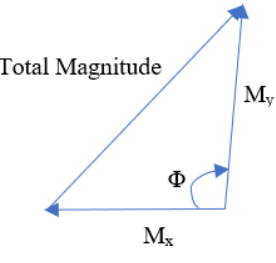
Figure 5. Pythagoras